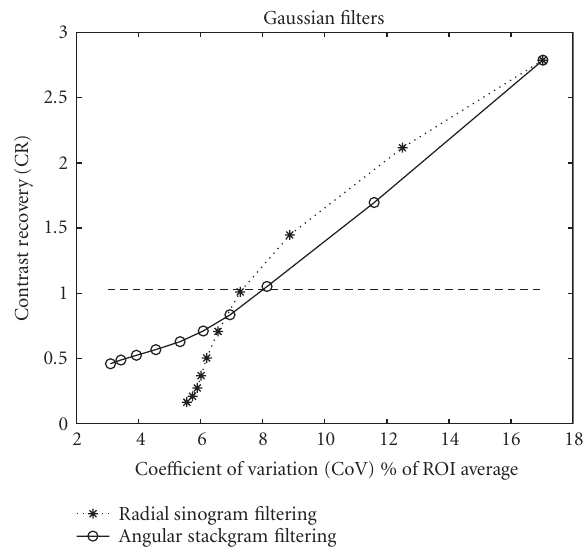
Figure 4: Resolution-noise tradeo ff curves for the compared meth- ods with the Gaussian filters. The points of the curves represent the 10 di ff erent filter kernels. The lines simply connect the points. The kernel width of the filters gets wider (i.e., the cut-o ff frequency of the lowpass filters decreases) from top-right to bottom-left. Accord- ing to the shown curves, radial sinogram filtering provides a better tradeo ff than angular stackgram filtering at the higher CR levels, whereas stackgram filtering performs better at the lower levels. The chosen or matched resolution level is also